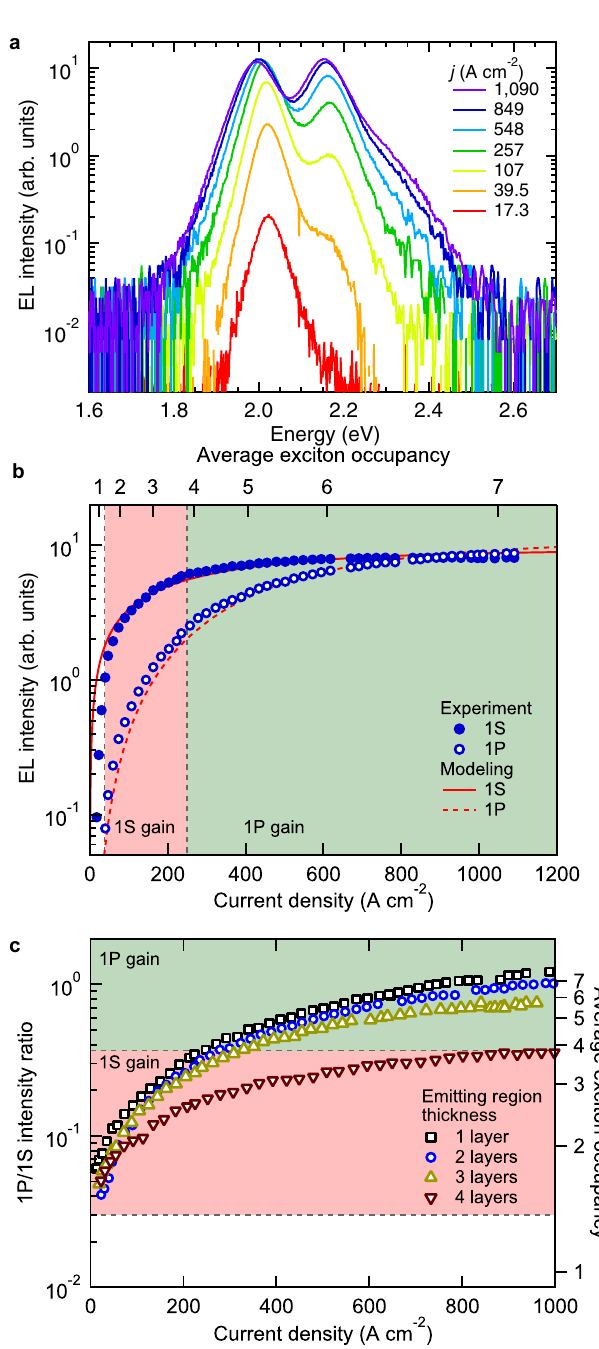
This implies that the maximal QD occupancy was ~6.8 excitons per dot on average. Optical-loss analysis . Modeling of the optical fi eld distribution in the 4-QD-layer device indicates that the mode con fi nement factor for the active QD region ( Γ QD ) is ~23% (see Supplementary Table 2). Based on variable stripe length measurements, saturated 1S gain of cg-QDs can be as high as ~800 cm − 1 (Supplementary Fig. 14a). This yields the modal gain of ~180 cm − 1 for our devices. Optical losses in our structures are primarily due to light absorption in the bottom ITO layer. The corresponding mode con fi nement factor ( Γ ITO ) is ~56% which yields modal losses of around 250 − 300 cm − 1 for standard ITO. However, the losses can be reduced approximately threefold (to ca . 80 − 100 cm − 1 ;